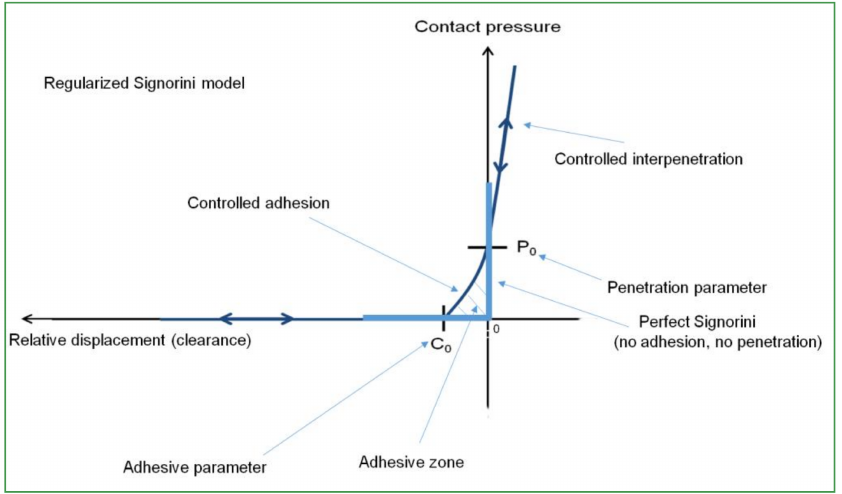
Figure 13. Exponential “softened” pressure-overclosure relationship.